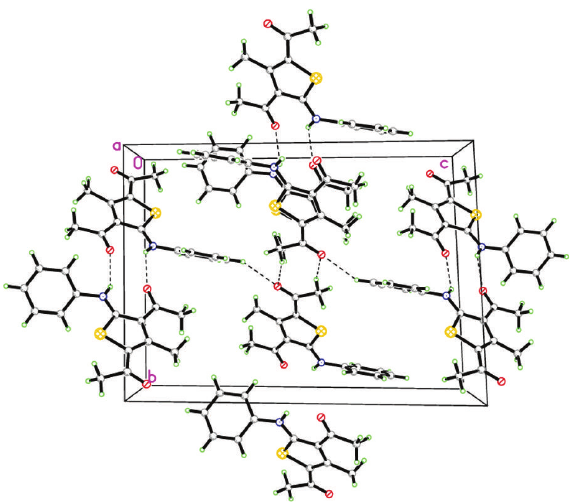
Figure 2: Molecular packing of the synthesized compound 2